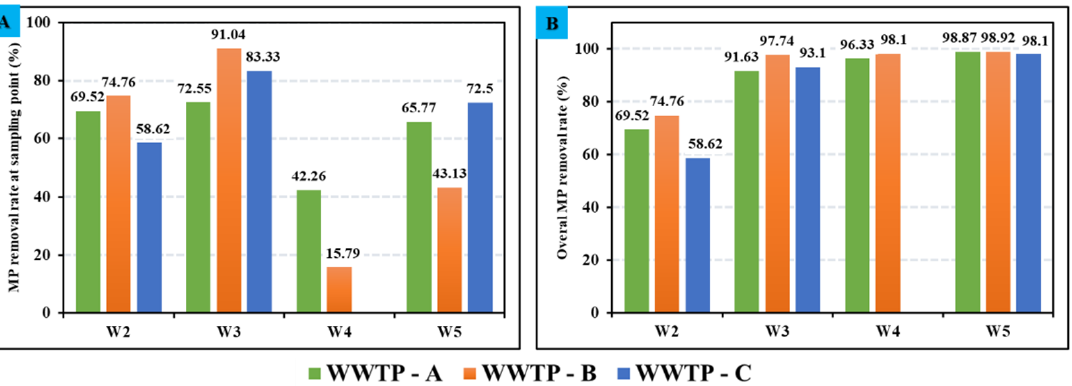
Figure 2. Removal of microplastic in different treatment processes. ( A ) Percentage of microplastics removed at samping point; ( B ) Overall percentage of microplastic